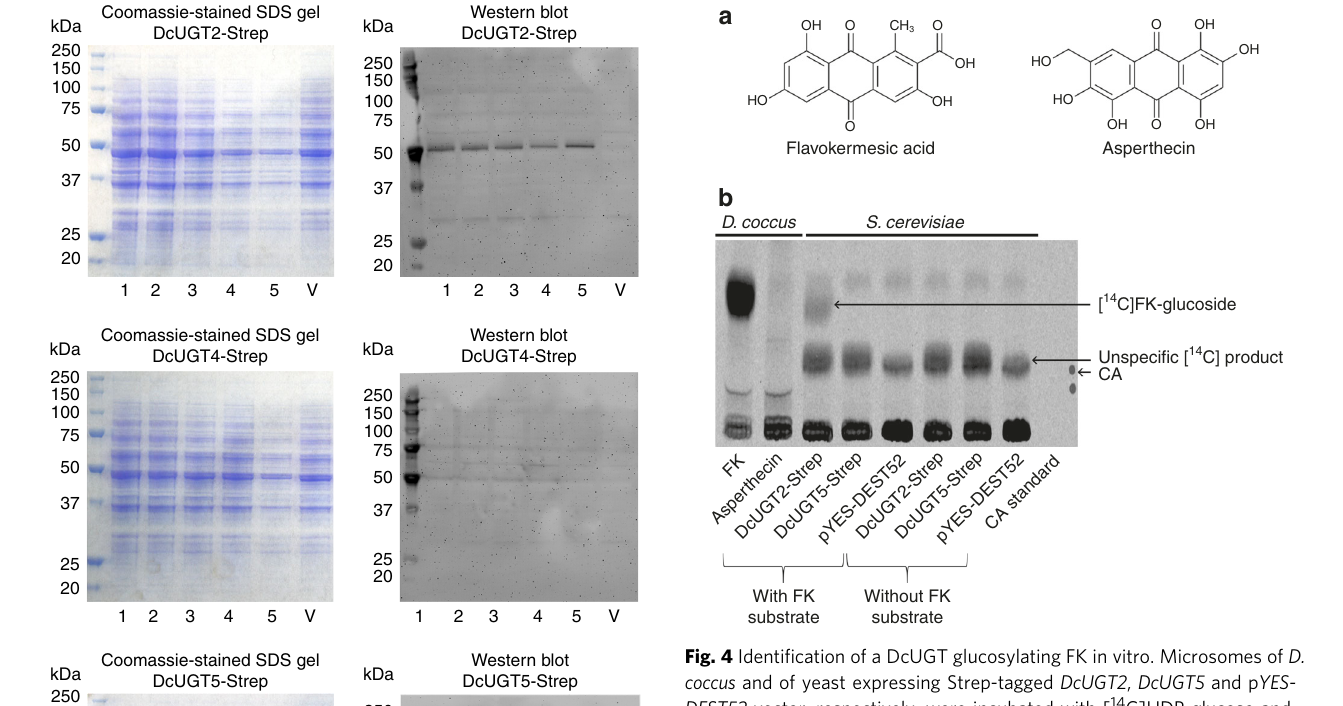
glucoside formed was caused by O- or C-glucosylation (Supple- mentary Fig. 2). In contrast to the O-glucoside control [ 14 C] Linamarin, [ 14 C]FK-glucoside was resistant to the viscozyme treatment and migrated with a similar relative migration (Rf) value as dcII, indicating that it was a C-glucoside. The D. coccus NATURE COMMUNICATIONS | 8: